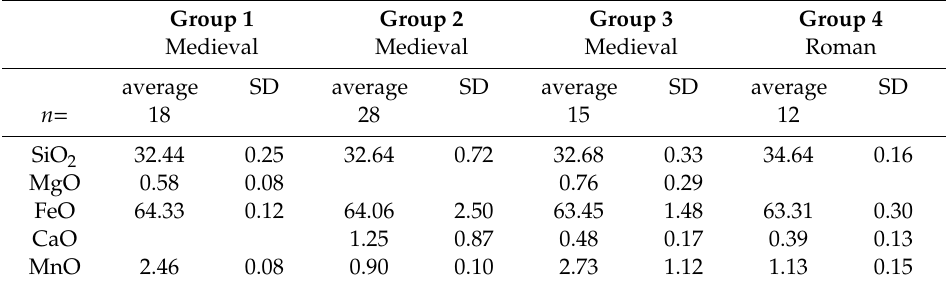
Table 3. SEM-EDS chemical composition of olivines in Roman and Medieval Age slag Groups